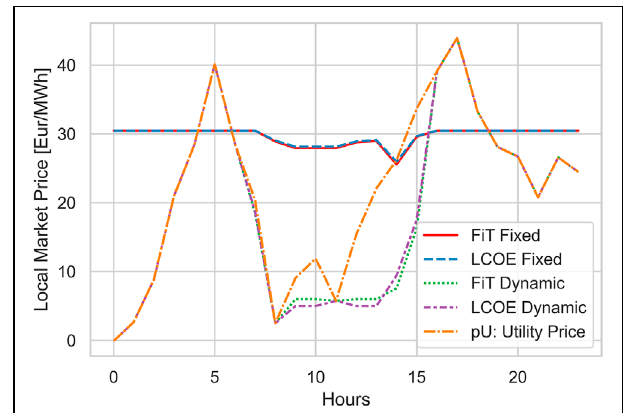
FIGURE 8 | Duration curves of the LEM prices for the scenarios with dynamic pricing thresholds.